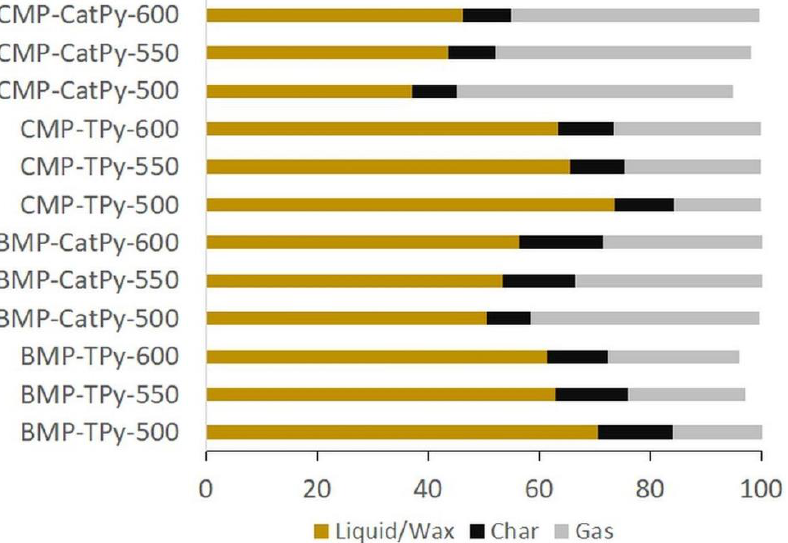
Figure 4. Product yields of thermal pyrolysis (TPy) and catalytic pyrolysis (CatPy) of BMP and CMP at 500 °C, 550 °C, and 600 °C.